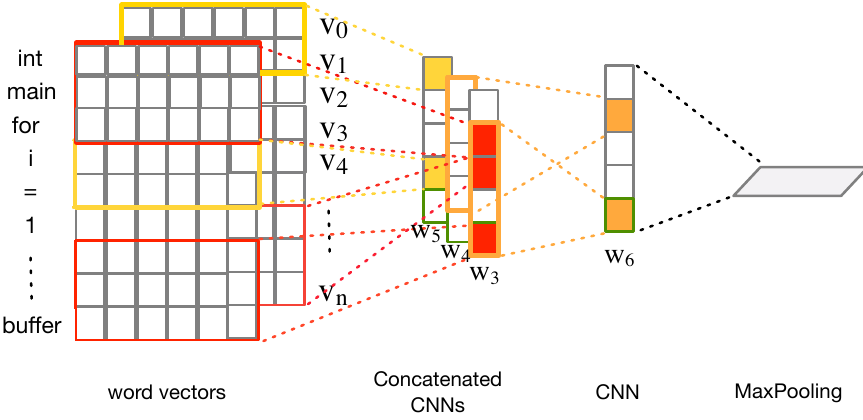
Figure 3. Features of convolutional neural networks